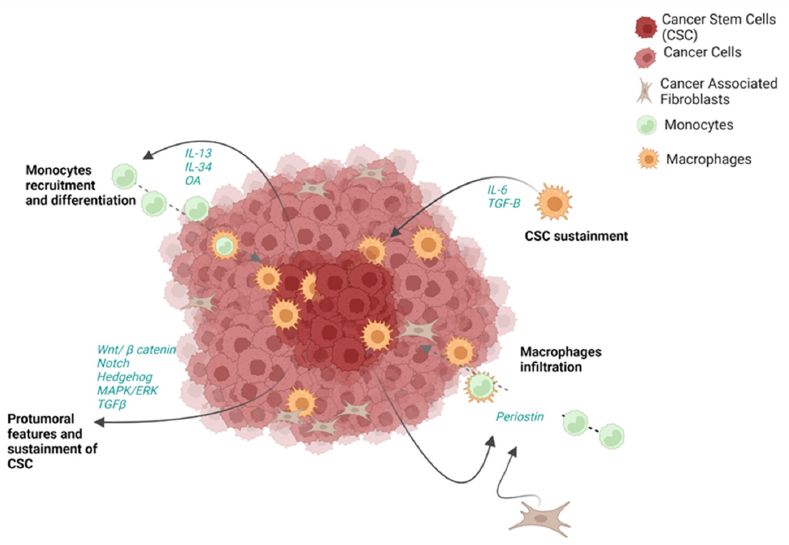
Figure 6. The crosstalk between immune cells and cancer stem cells. Cancer stem cells (CSCs) are involved in a circular network of connection with tumor cells and the other components of the tumor microenvironment (TME). Protumoral features and sustainment of CSC are supported by the dysregulation of Wnt/ β , Notch, Hedgehog, MAPK/ERK and TGF- β which leads to proliferation, self-renewal and aggressiveness. CSC sustainment is also promoted by macrophages through the release of IL-6 and TGF- β . On the other hand, CSCs themselves can shape immune cell behavior, affecting monocyte recruitment and differentiation, by secreting IL-13, IL-34 and OA. Furthermore, periostin released by CSCs and CAFs can guide macrophage recruitment and infiltration in CCA tissue.